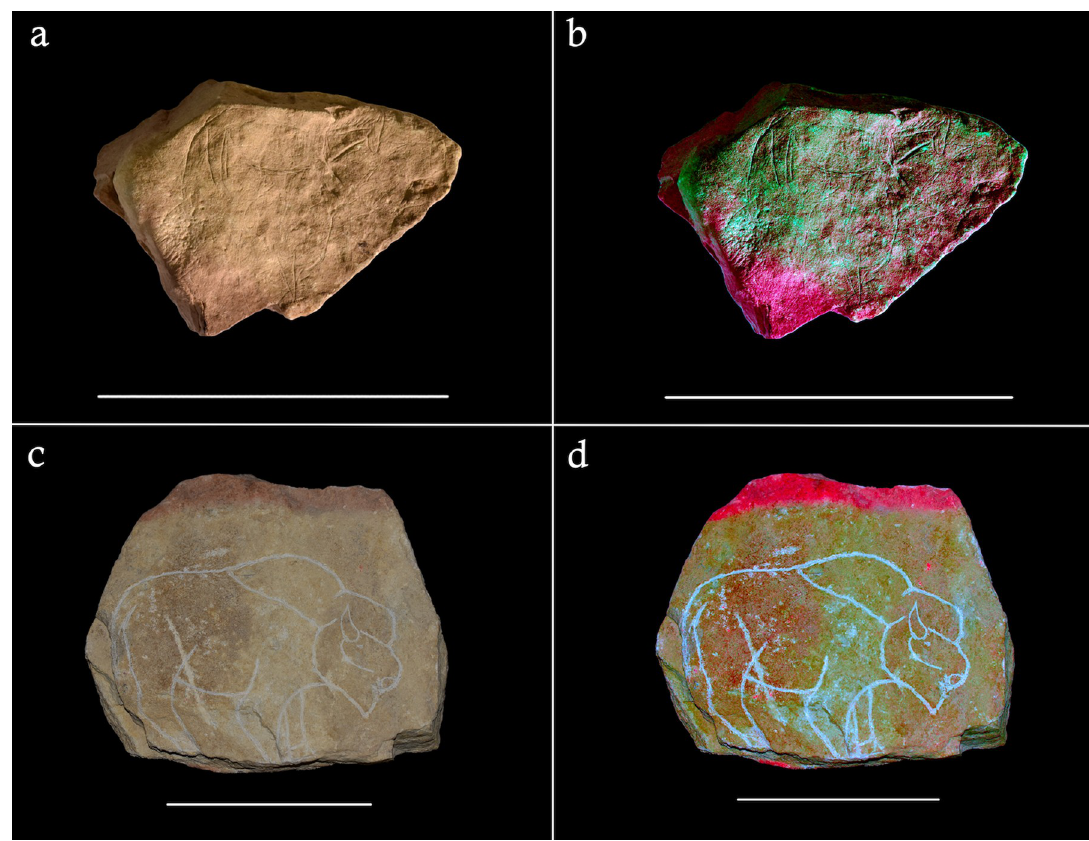
Fig 4. Photographs showing a comparison between Montastruc plaquette (a, b) and replica plaquette FS1.2 (c, d) used in experiment E. b and d are DStretch © manipulated images using the LAB colourspace matrix to enhance pink discoloration caused by heating. Scale bar below each plaquette is 10cm in